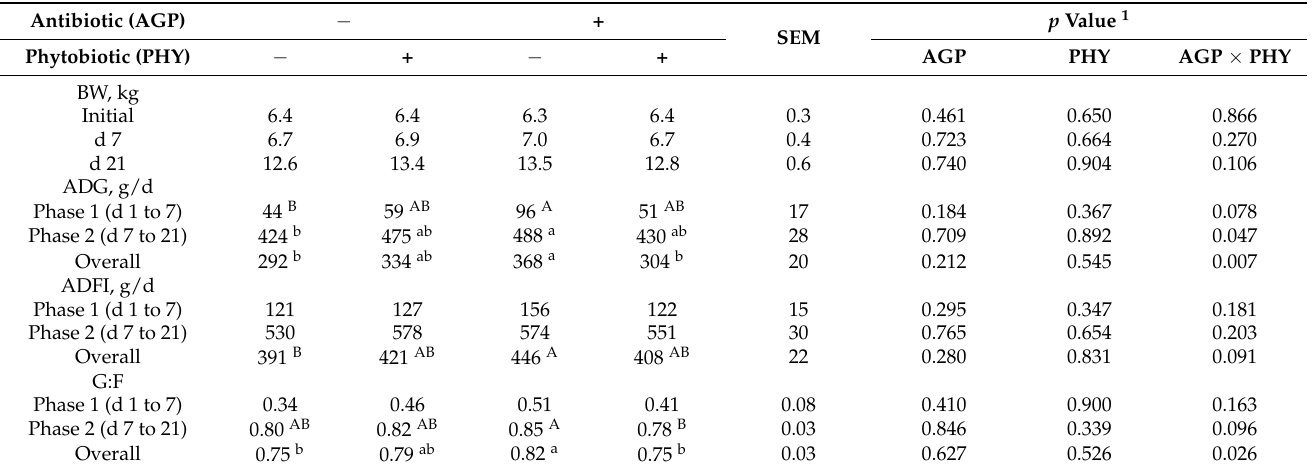
Table 3. Growth performance of nursery pigs fed diets supplemented with phytobiotics and antibi- otics as growth promoters (Exp.